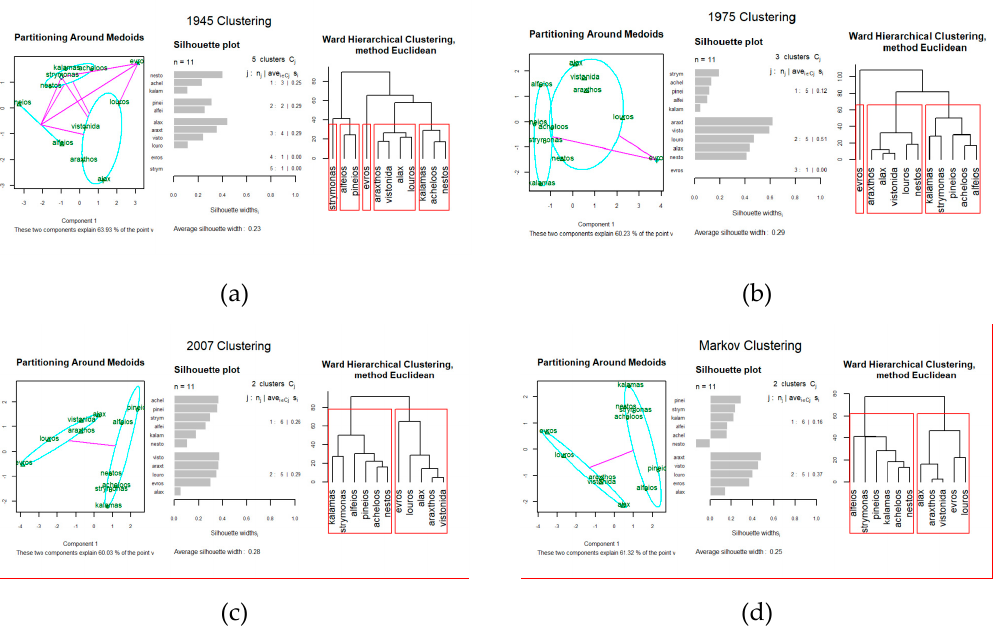
Figure 6. Cluster analysis outputs of landscape composition for the years ( a ) 1945, ( b ) 1975, ( c ) 2007 and ( d ) for future projection. The first two columns refer to the non-hierarchical partitioning around medoids (PAM) method. The third column shows the outputs of hierarchical clustering. Labels of deltaic areas when abbreviated: achel: Acheloos; alax: Aliakmonas-Axios; alfei: Alfeios; araxt: Arachthos; evros: Evros; louro Louros; nesto: Nestos; pinei: Pineios; strymo: Strymonas; visto: Vistonida.